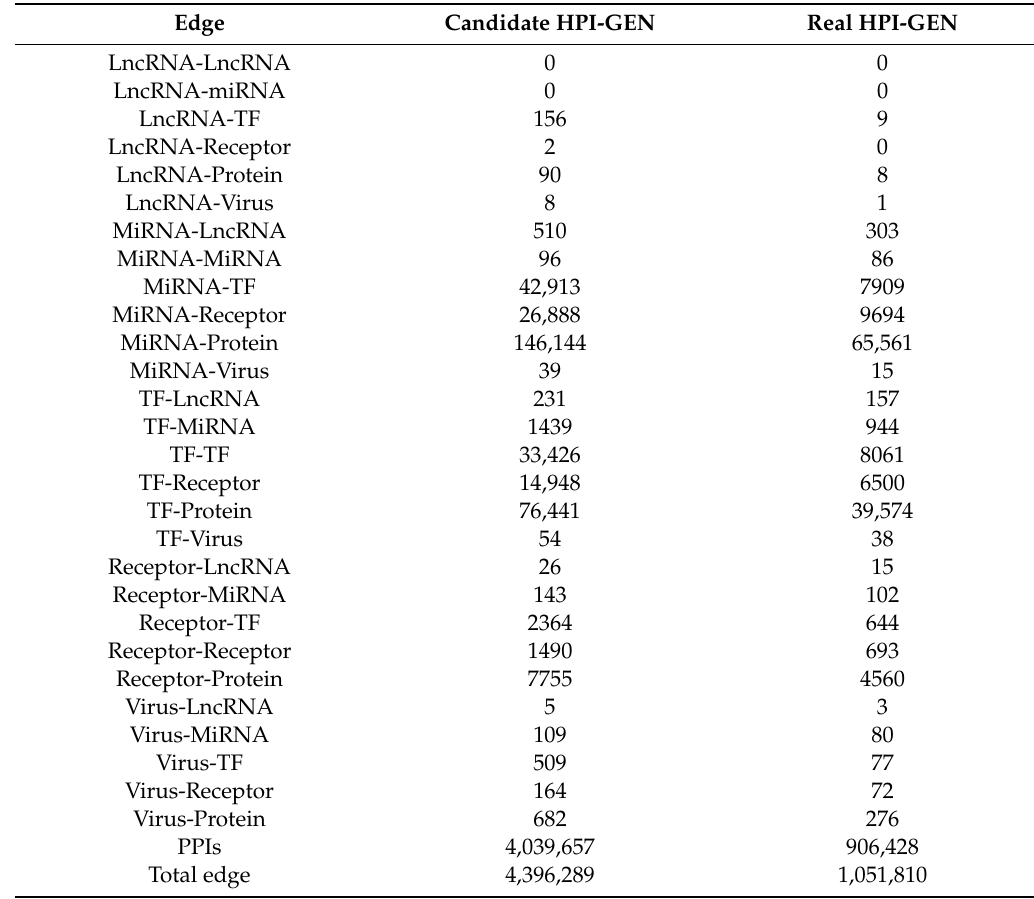
Table 2. The total number of edges in candidate interspecies HPI-GEN and identified interspecies HPI-GEN during HBV